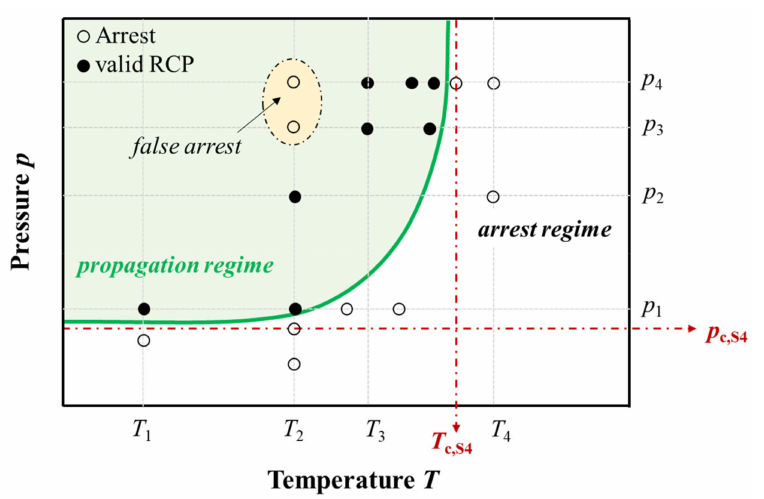
Figure 1. Schematic of crack propagation and arrest regimes for RCP during S4 testing as well as false arrest points within the propagation regime (according to [3]).